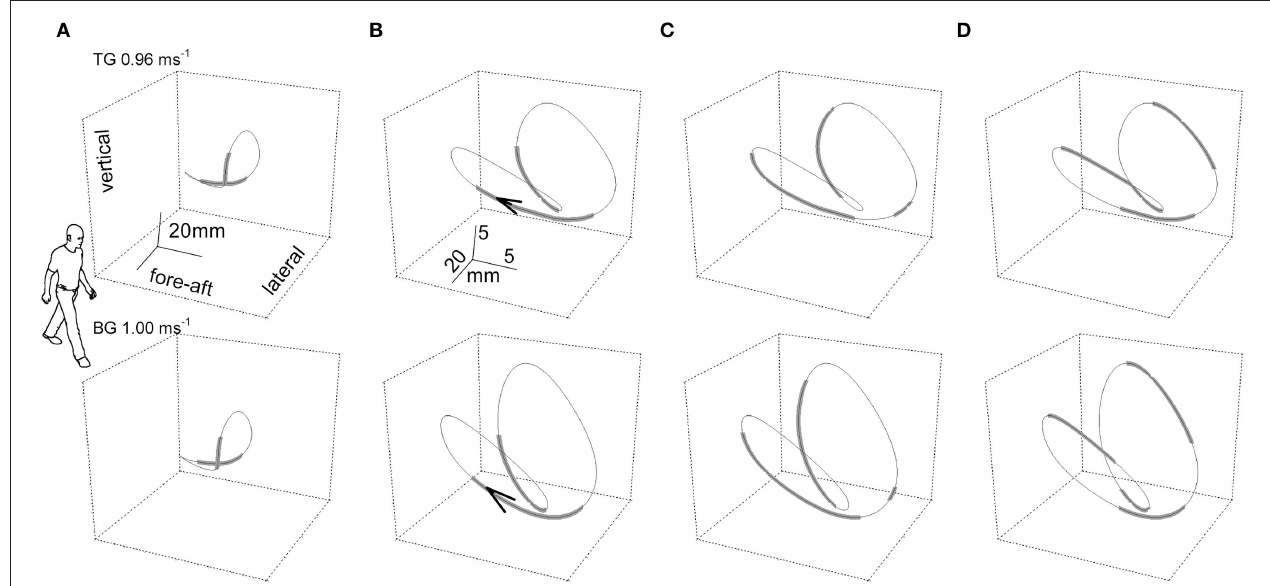
FIGURE 3 | The “bow-tie” path of the body center of mass (CoM) averaged over a series of strides. In the upper and the lower row of panels, two representative subjects walked at 0.96 and 1m s − 1 , respectively. Subject TG (upper row column) was a man, 23 years of age, 1.78m in height, 74kg in weight with a leg length (superior iliac spine to ground) of 0.91m. Subject BG (lower row) was a man, 30 years of age, 1.73m in height, 66kg in weight with a leg length (superior iliac spine to ground) of 0.88m. Six subsequent strides were recorded per subject. In the (A) column, the curve gives the CoM path and thickened segments correspond to the double foot-ground contacts. The human form outline (arbitrary size) facilitates recognition of the spatial orientation of the figure. In columns (B–D) , the scaling of the curves is modified for graphic clarity. (B) Foot-ground contact phases. The arrow tip marks the conventional beginning of the stride; i.e., the point where the forward speed reaches a maximum after the right foot strike. (C) Thickened tracts mark the segments of the trajectory where the curvature is classified as low, at or below 0.05 mm − 1 (i.e., radius of curvature at or above 20mm). (D) Thickened tracts mark the segments of the trajectory where the instantaneous recovery of mechanical energy, R inst , is at or below 0.7. It can be seen that the phases of high curvature (thinner tract in C ) largely overlap the single stance phases (thinner tracts in B ), and phases with low values of energy transfer (R, thicker tracts in D ). Taken from Tesio et al. ( 27), used with